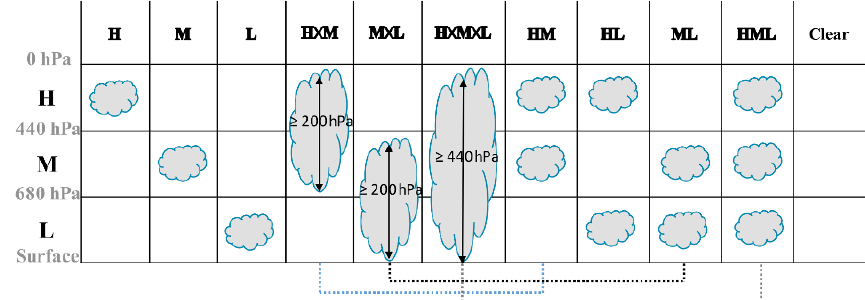
Figure 1. The original 10 CVS classes of Oreopoulos et al. (2017) used as a reference for the comparison of this paper. The multilayer CVS classes other than HL are merged in this paper, thus reducing the total number of CVS classes to seven. We essentially do no distinguish between contiguous and noncontiguous clouds in adjacent standard layers. Dotted lines show which pairs of CVS classes have been combined for this